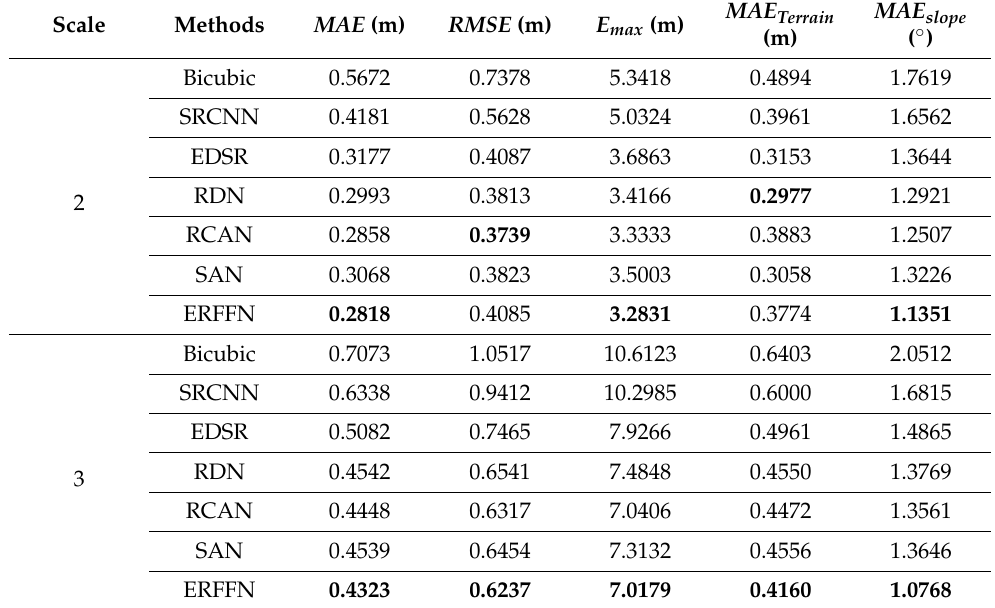
Table 3. Performance evaluation of SR models at various reconstruction scales trained on Loess Plateau DEM